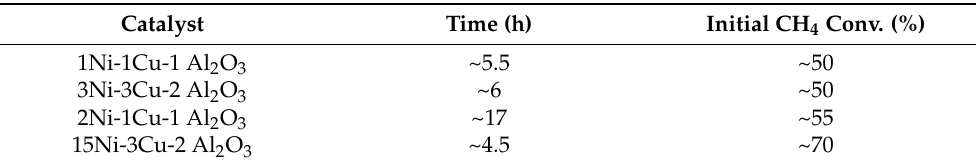
Table 10. The catalytic performance of Ni-Cu-Al 2 O 3 catalysts prepared via coprecipitation method and tested at 740 ◦ C and 1 atm